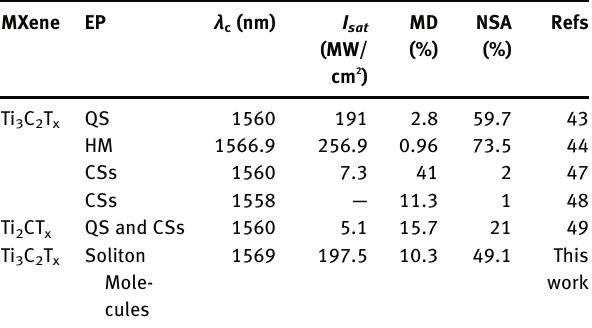
λ C ,Centerwavelength;EP,Experimentalphenomena;MD,Modulation depth; NSA, Non-saturation absorbance; QS: Q-Switching;